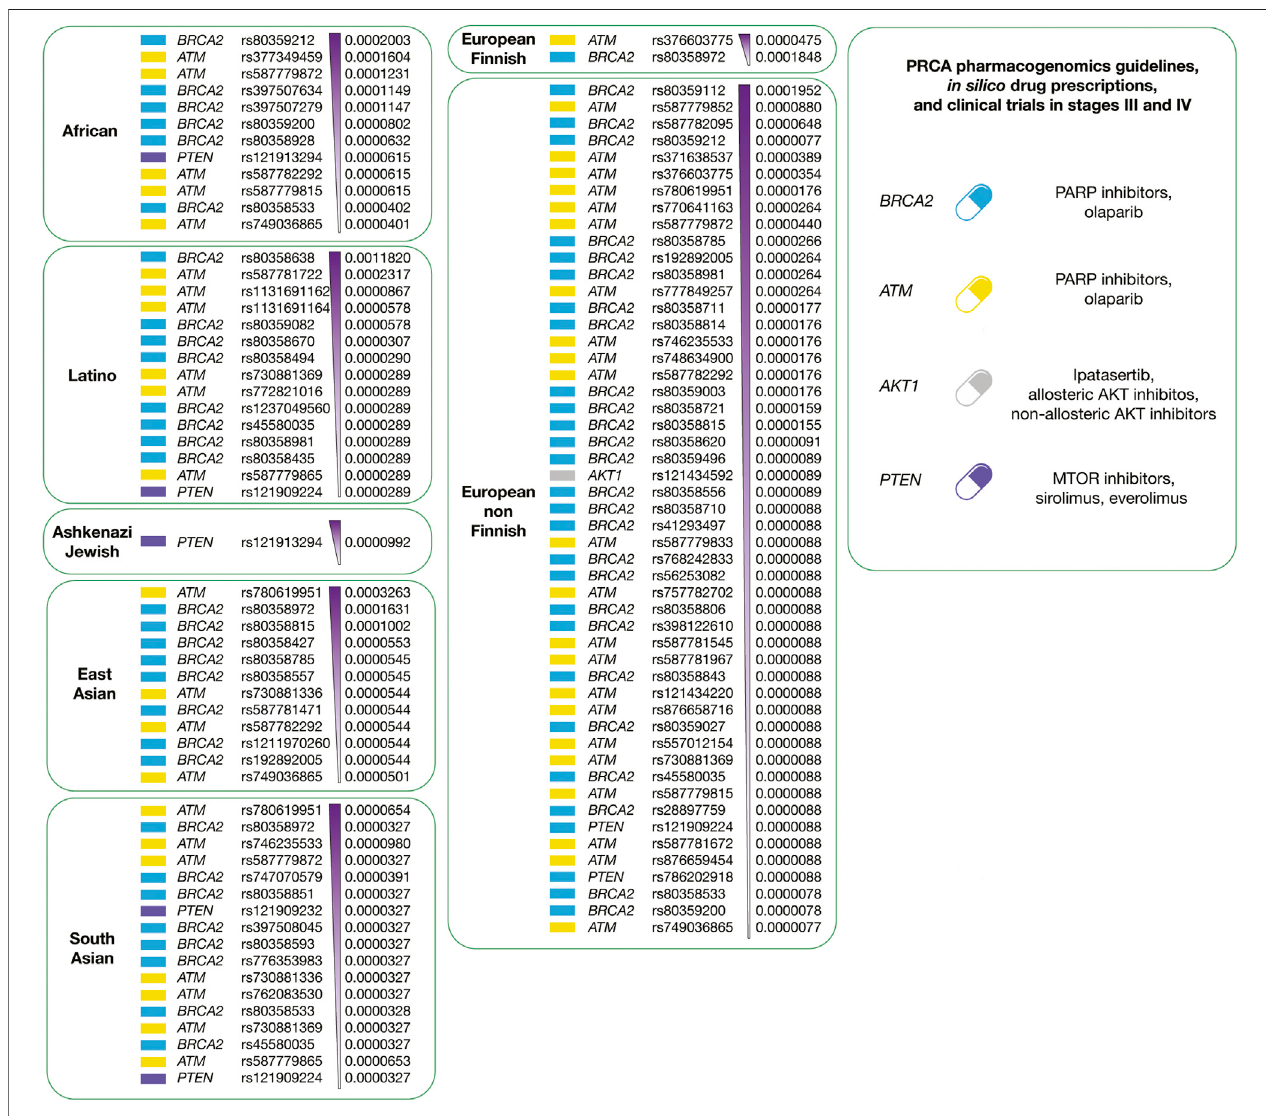
FIGURE 11 | Precision medicine of PRCA per human population. On the left, druggable PRCA driver proteins carrying known oncogenic variants with the highest allele frequencies and the highest deleteriousness scores per human population. On the right, integration of pharmacogenomics guidelines, drug prescription, and clinical trials according to druggable PRCA driver